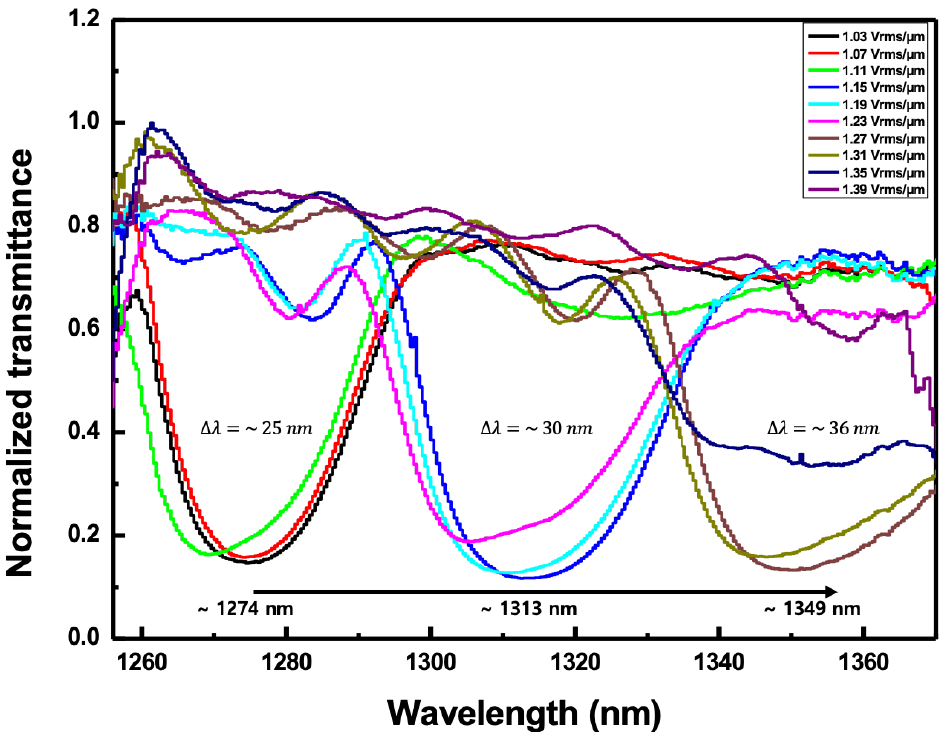
Figure 7. The normalized transmitted spectra according to the applied electric field when the angle of incidence to the CLC cell was fixed to 36 ◦ .